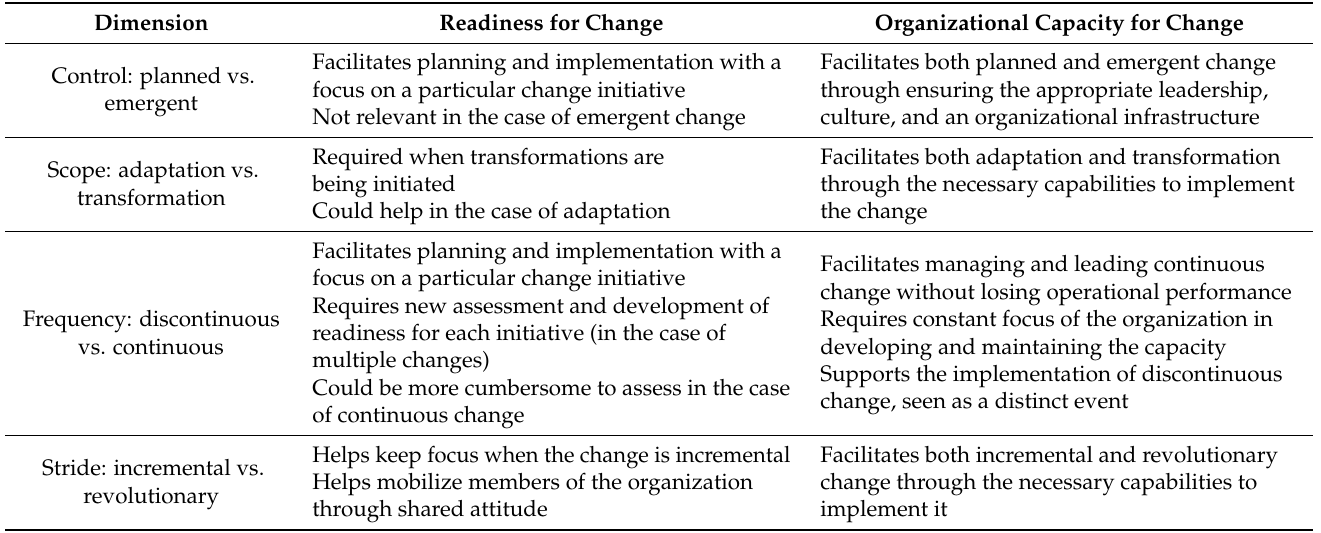
Table 3 below maps the role of the two concepts to selected dimensions of change and their attributes. Table 3. Types of